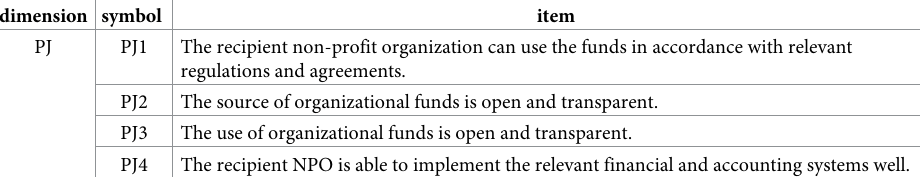
Table 4. Financial procedure fairness scale.